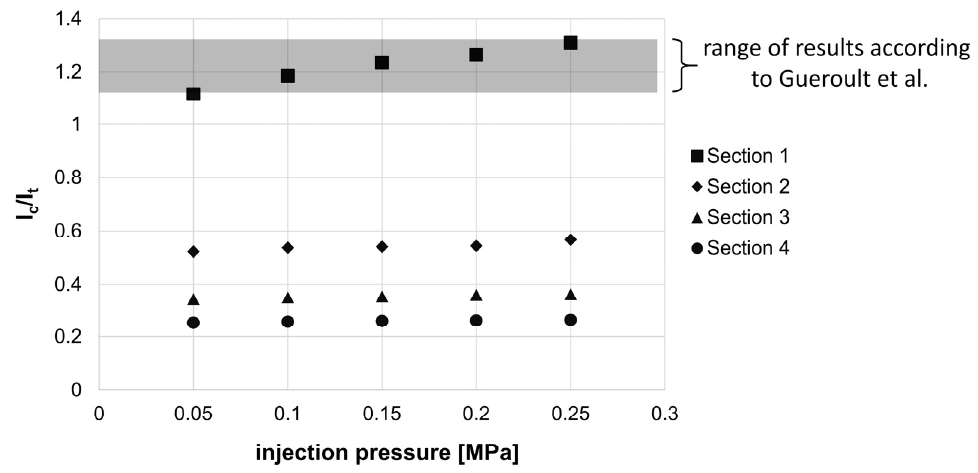
Figure 12. Division of the total volume flow into crossflow 𝑄(cid:4662) (cid:3047) into the tow and longitudinal flow 𝑄(cid:4662) (cid:3030) in the channel.